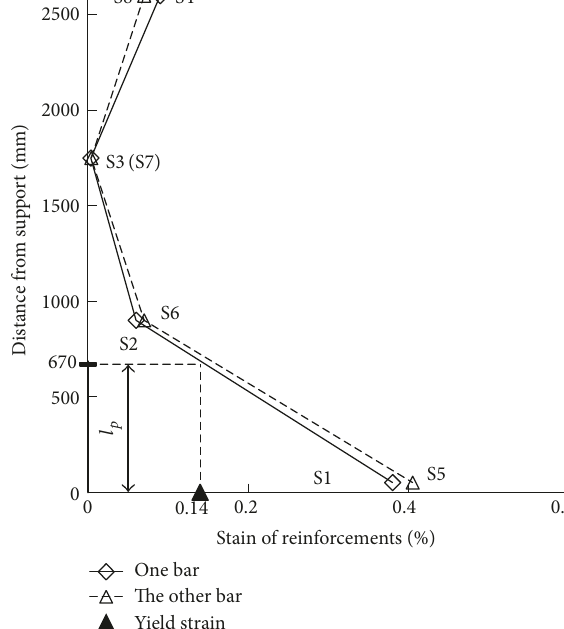
Figure 17: Strain distribution of longitudinal reinforcements of specimen 1TB2 at maximum